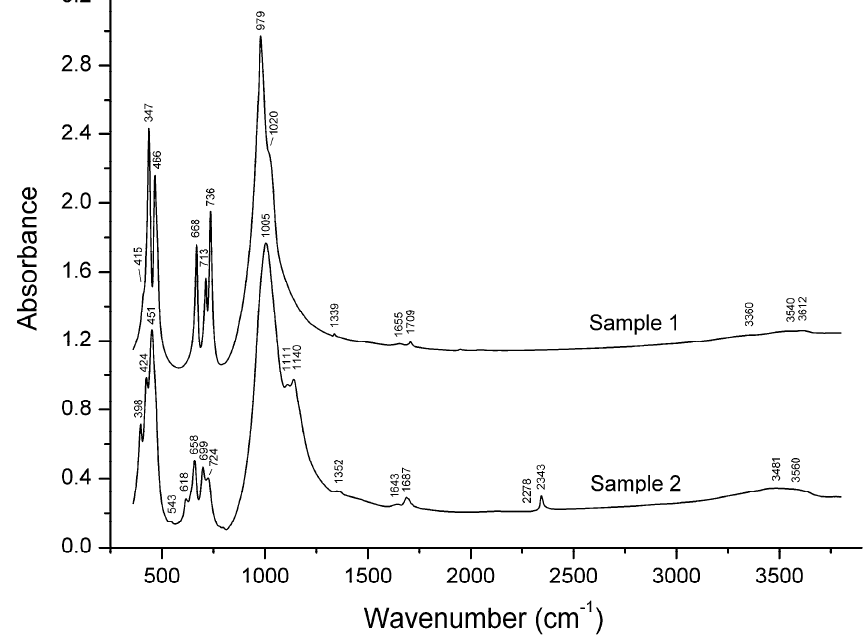
Figure 5. Infrared absorption spectra of sodalite and nosean (Samples 1 and 2).